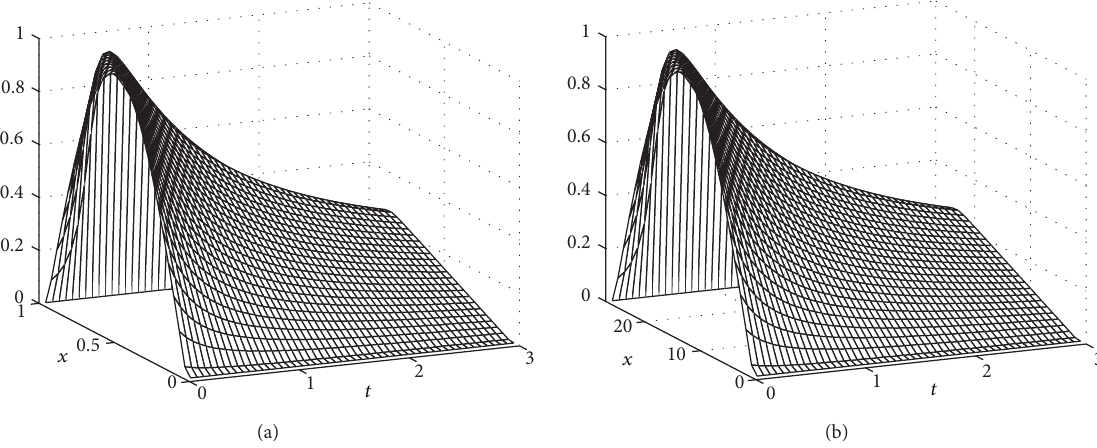
Figure 1: The numerical solutions of Burgers’ equation at 𝑡 ∈ [0,3] obtained by ERK method and EEI method.